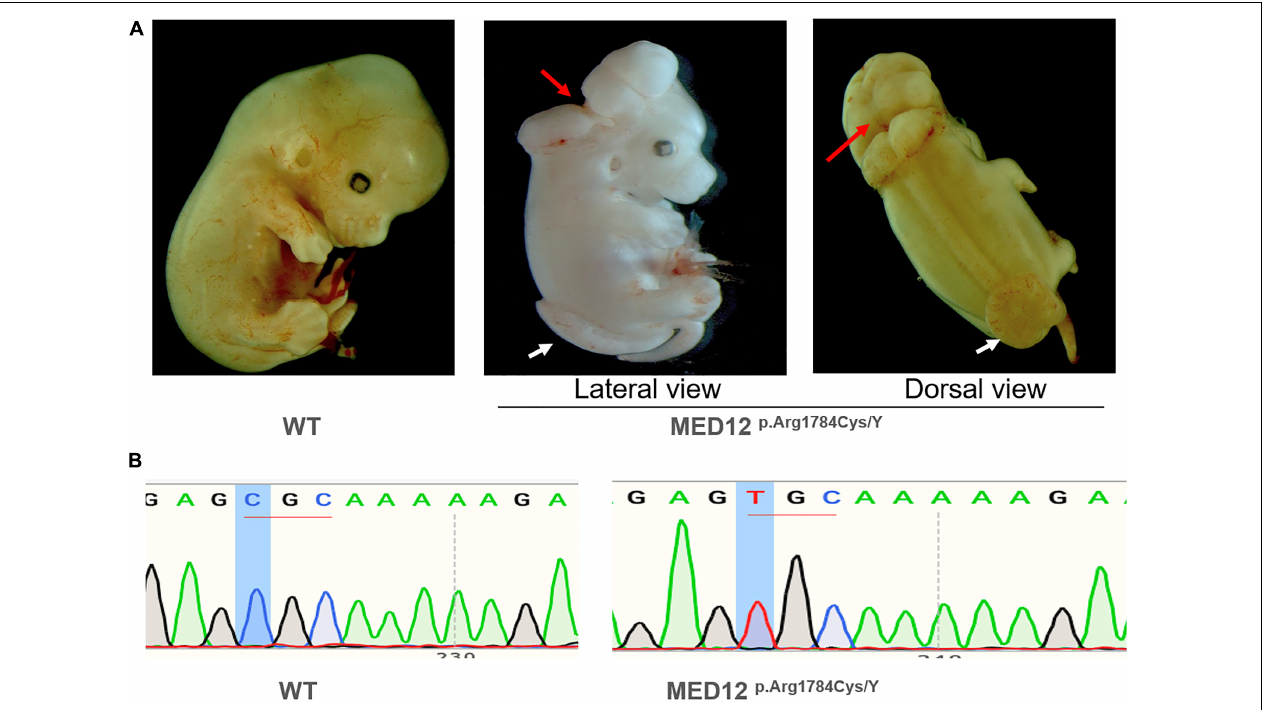
FIGURE 5 | The knock-in of MED12 c.5344C > T (p.Arg1784Cys) on mouse embryogenesis. (A) The knock-in of MED12 c.5344C > T (p.Arg1784Cys) produced mouse embryos displaying exencephaly and spina bifida phenotypes. The lesion site of exencephaly was indicated by the red arrow, while the spina bifida lesion site was indicated by the white arrow. The phenotypes of mice were observed and captured under a 6X microscope. (B) DNA Sanger sequencing on the CRISPR/Cas9